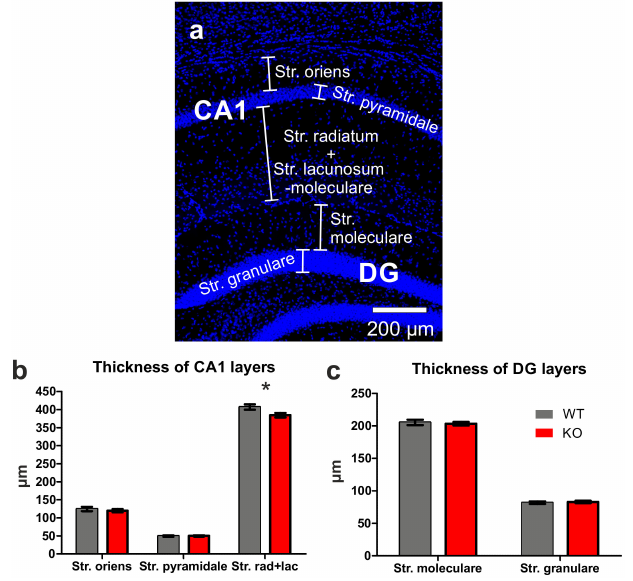
Figure 2. Thickness of different hippocampal layers. ( a ) Serial coronal sections counterstained with DAPI were used for the analysis of the thickness of different layers of the hippocampal area CA1, as well as of the dentate gyrus (DG). ( b ) Analysis of the different layers of the hippocampal area revealed a significant reduction in mean size ( p = 0.042) only in the case of the stratum radiatum and stratum lacunosum-moleculare, while in the other layers, no significant changes in the mean thickness were seen. ( c ) Analysis of mean thicknesses of the molecular and granular layers of the upper leaf of the dentate gyrus revealed no significant differences between age-matched FTSJ1-deficient mice and their control littermates. Data are expressed as mean ± SEM. * indicates significant differences ( p < 0.05).